Question: What does this figure show? Answer in one sentence.
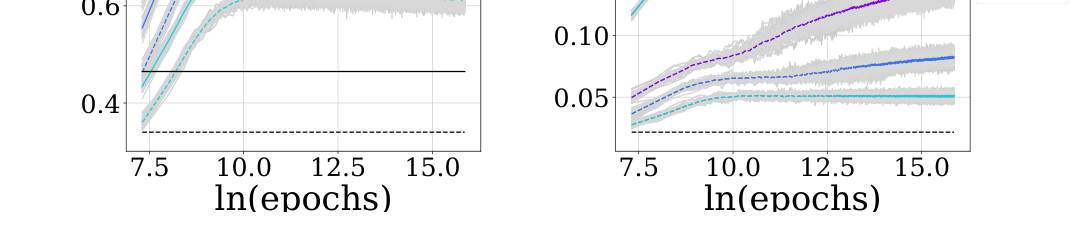
Answer: Learnability of target components. Here we track the output projection of network onto linear (lhs) and cubic (rhs) components of the target, both for test and train data, as a function of the ln of the epochs. The linear component of the target is given by the vector in data-space, whose components are given by- H1(w∗· xµ), with xµ drawn either from the train or the test. Similarly, the cubic component is given by- ϵH3(w∗·xµ), where the ϵ factor is from the definition of the target. The average output as a function of either the train data or the test data can was be projected onto these normalized components. This computation was preformed on an ensemble of 50 networks, for networks of three different width. The average quantities are shown in color, and the individual networks in gray.